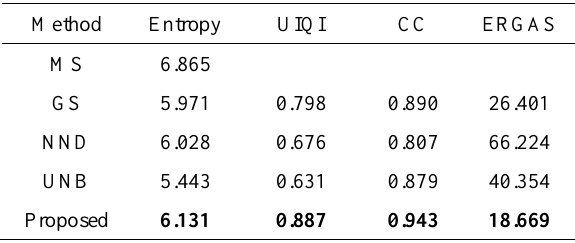
Table 4. Quality evaluation of fused images: Cropland (corresponding to Figure 4). The best performance of each metric is in